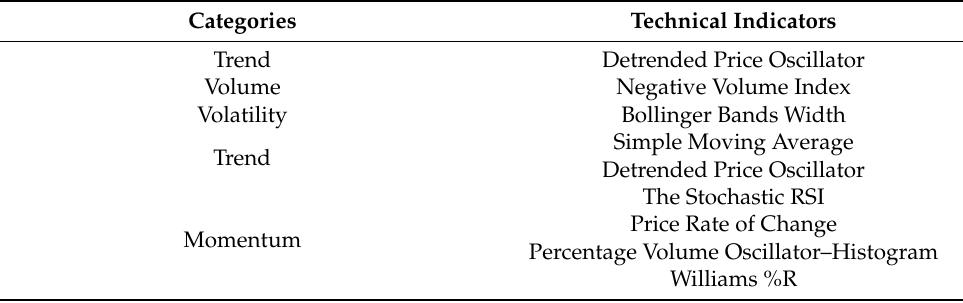
Table 2. Categories and names of technical indicators.